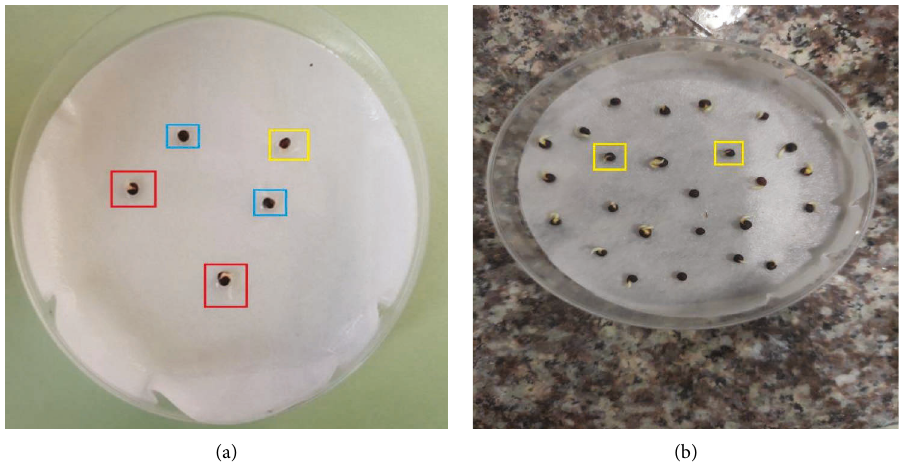
Figure 5: Germinated and ungerminated seeds. (a) Poorly characterized buds. (b) Short